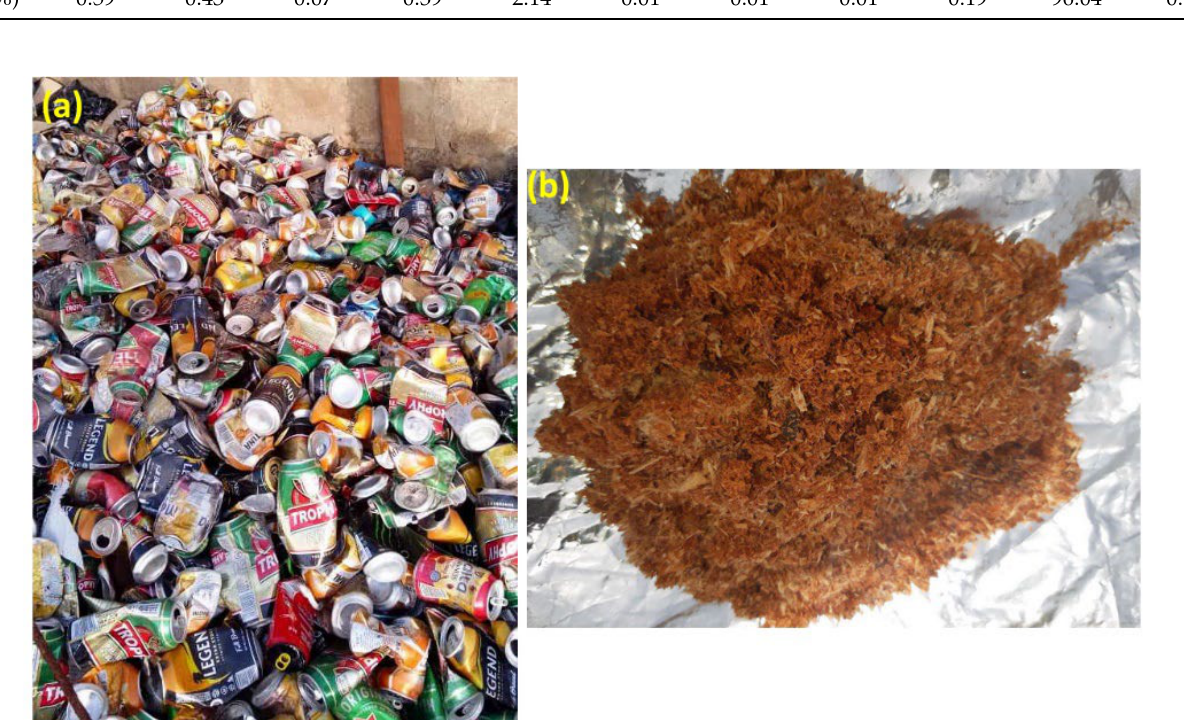
Figure 1. ( a ) Aluminum scraps; ( b ) wood particles.